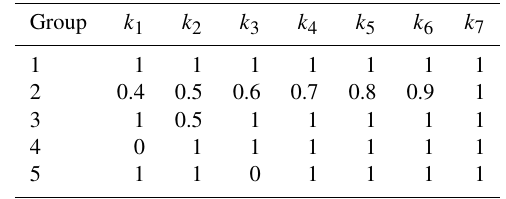
Table 3. Setting of joint motion